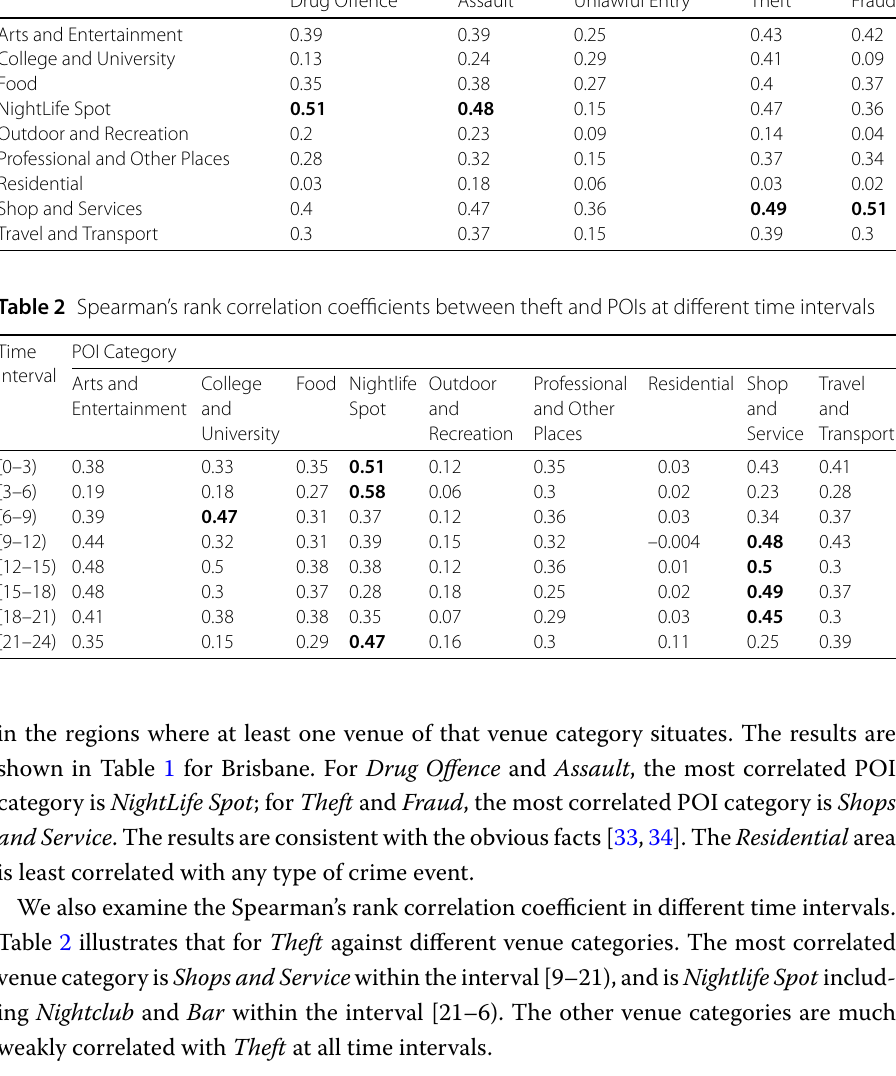
Table 1 Spearman’s rank correlation coefficients between POI categories and crime event types POI Category Type of crime event Arts and Entertainment